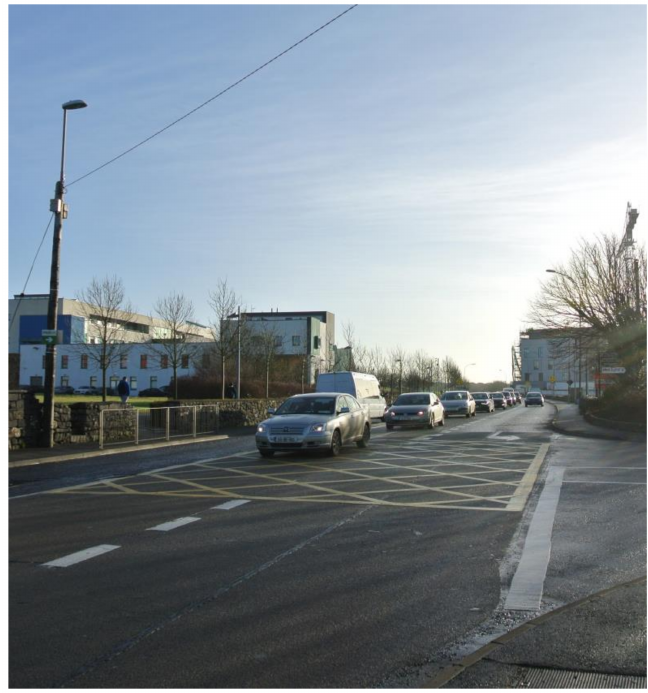
Figure 16. Old Dublin Road, Galway.